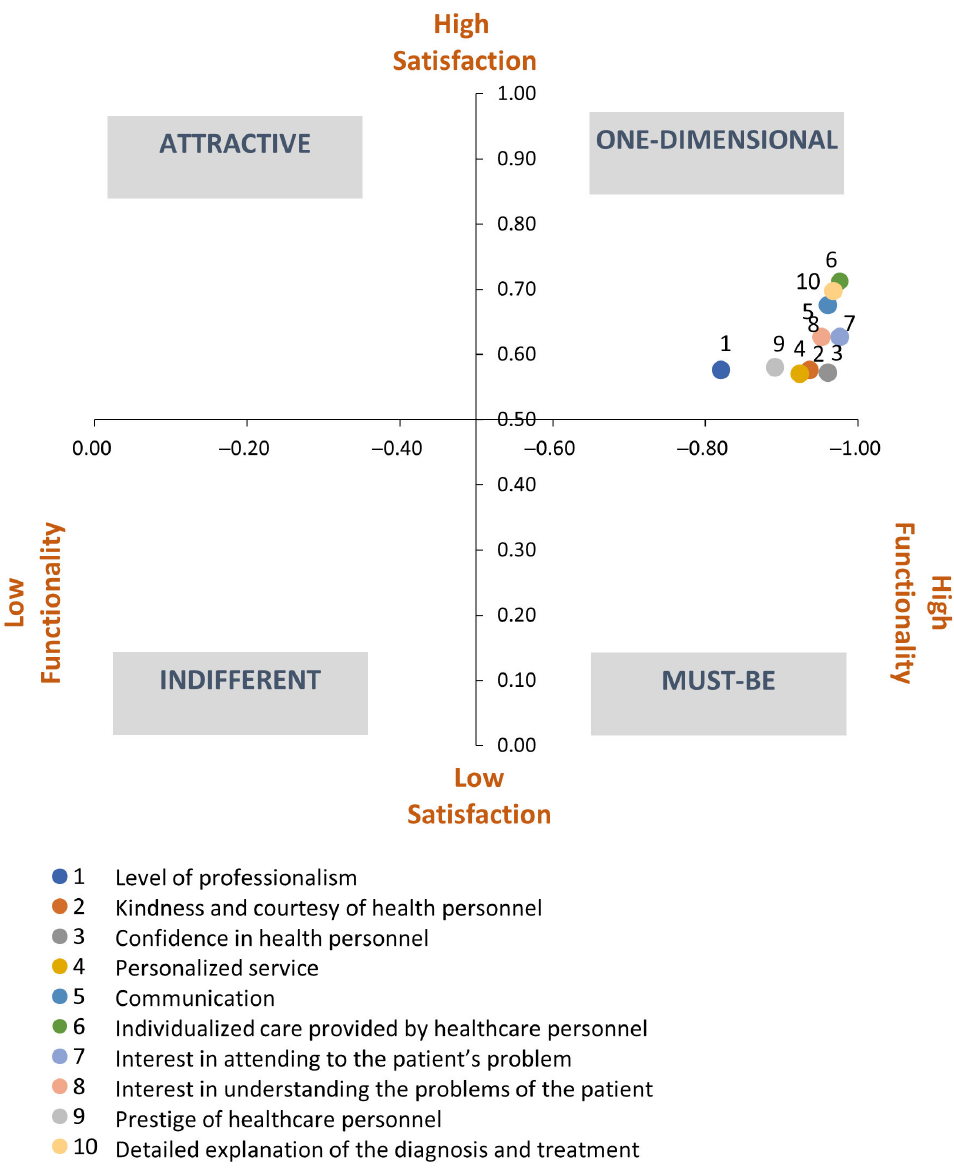
Figure 2. Classification of the attributes of the health personnel